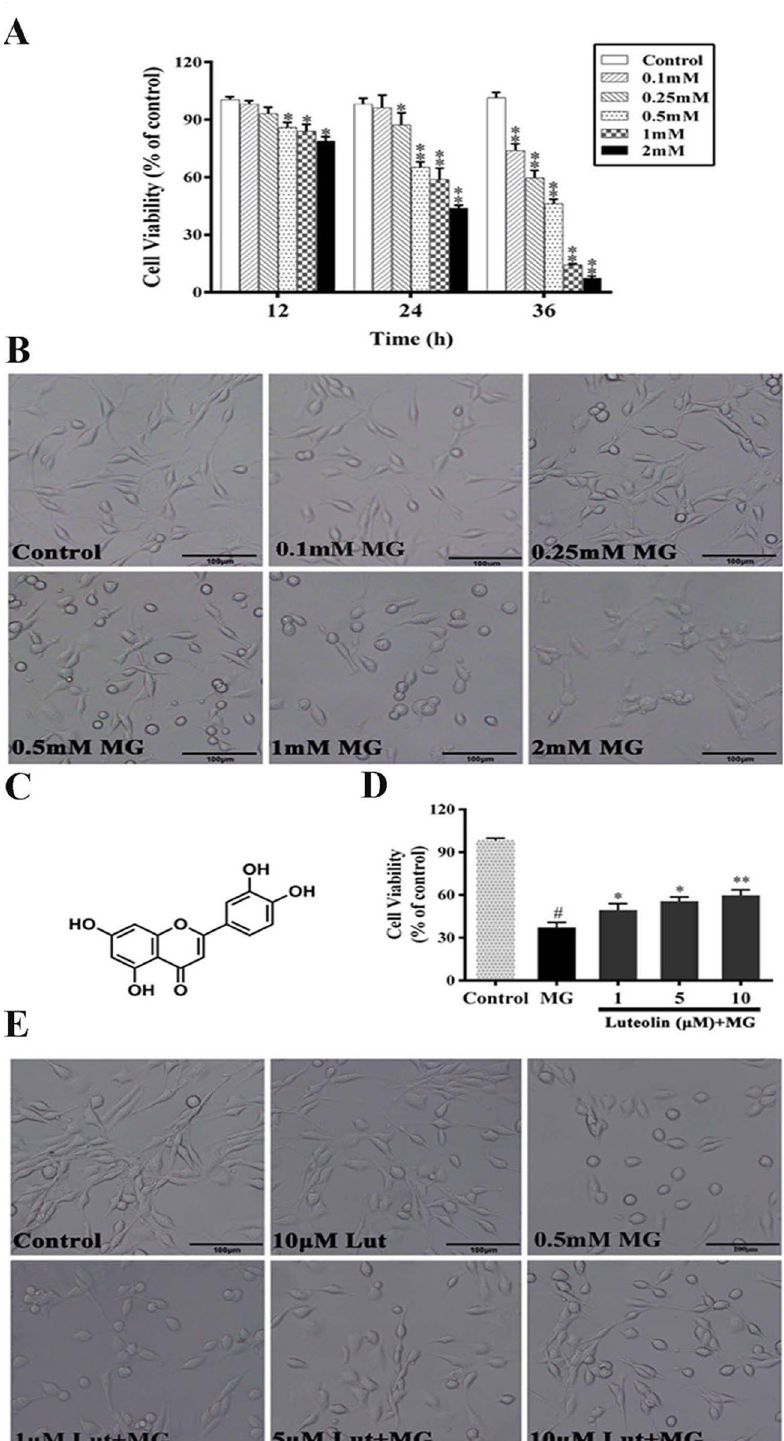
Figure 1. Luteolin (Lut) prevented MG-induced decrease in cell viability in a dose-dependent manner. ( A ) MTT assays were performed to detect viability of PC12 cells treated with MG (0.1–2.0 mM) for 12 h, 24 h and 36 h. Results are expressed relative to control and are presented as means ± SD of three independent experiments, each performed in triplicate. * p < 0.05, ** p < 0.01 vs control group. ( B ) Representative photographs of cell morphology of PC12 cells treated with MG (0.1–2.0 mM) for 36 h. Morphological changes of PC12 cells were observed by phase-contrasted microscopy. ( C ) Chemical structure of Lut. ( D ) Morphological changes of PC12 cells, pretreated with Lut for 3 h, followed by MG (0.5 mM) for 36 h. Data are presented as means ± SD of three independent experiments, each performed in triplicate. # p < 0.01 vs control group; * p < 0.05 and ** p < 0.01 vs MG group. ( E ) Representative images of Lut-induced protection against MG-induced cytotoxicity. Cells were observed by phase-contrast